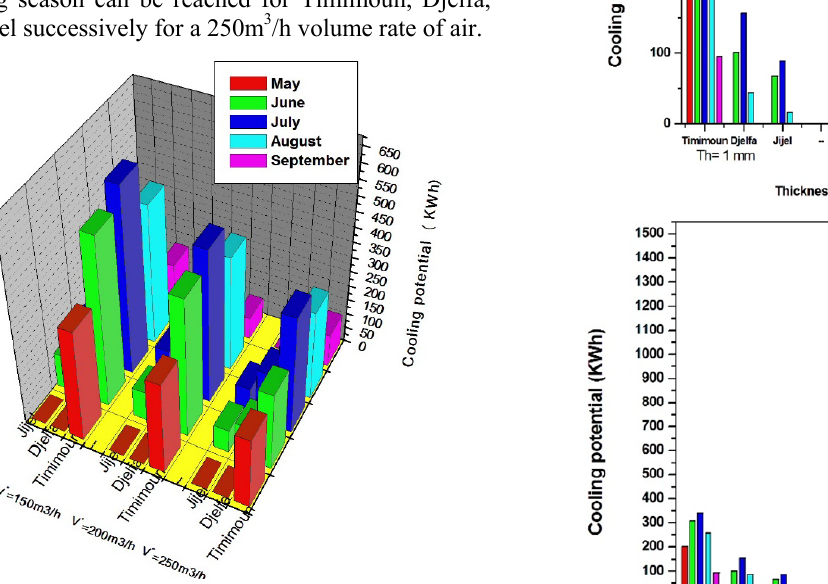
Figure 7. The monthly cooling energy provided by the EAHE for different air